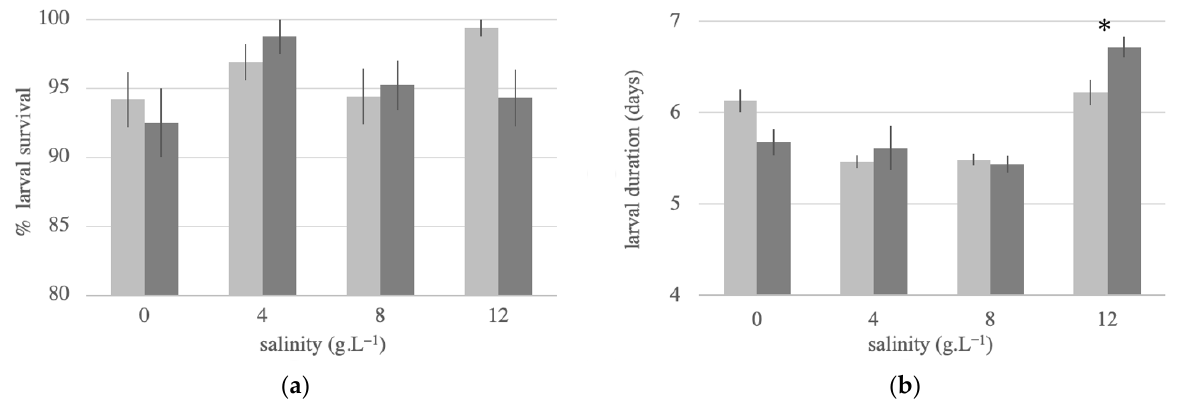
Figure 3. Effect of water salinity on the larval development success and duration. ( a ) Average percent of larvae that successfully pupated in each container. ( b ) Average number of days until pupation for larvae in each container. Light grey columns represent insecticide-susceptible larvae Vs, and dark grey columns represent insecticide-resistant larvae Vr. Bars represent S.E.M. Significant differences between strains within each salinity group are represented by an asterisk.